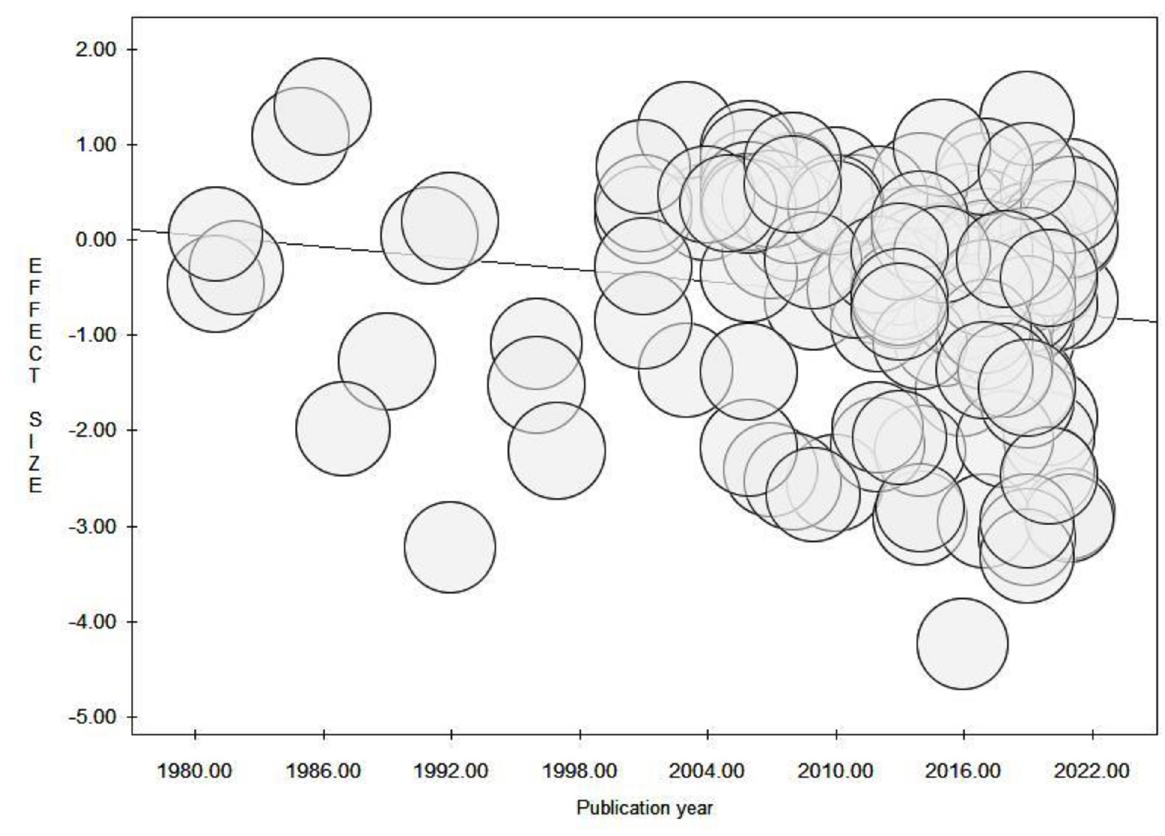
Fig 2. Meta-regression (random-effects model) of the prevalence of unemployment according to time.